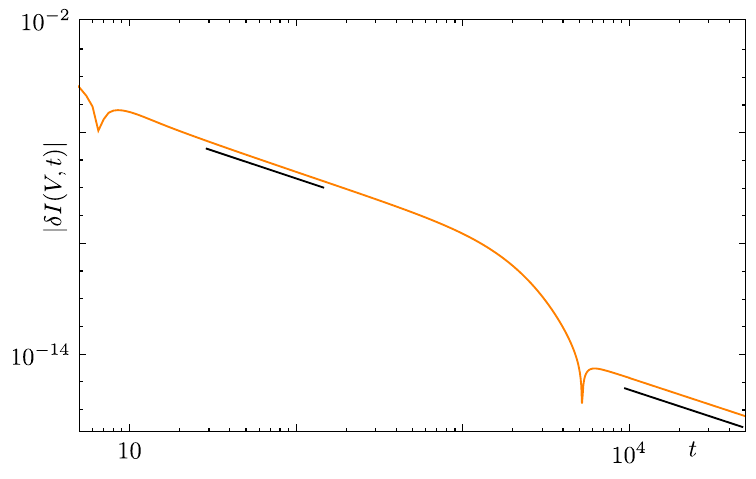
= 0.9 and i and i , time is f